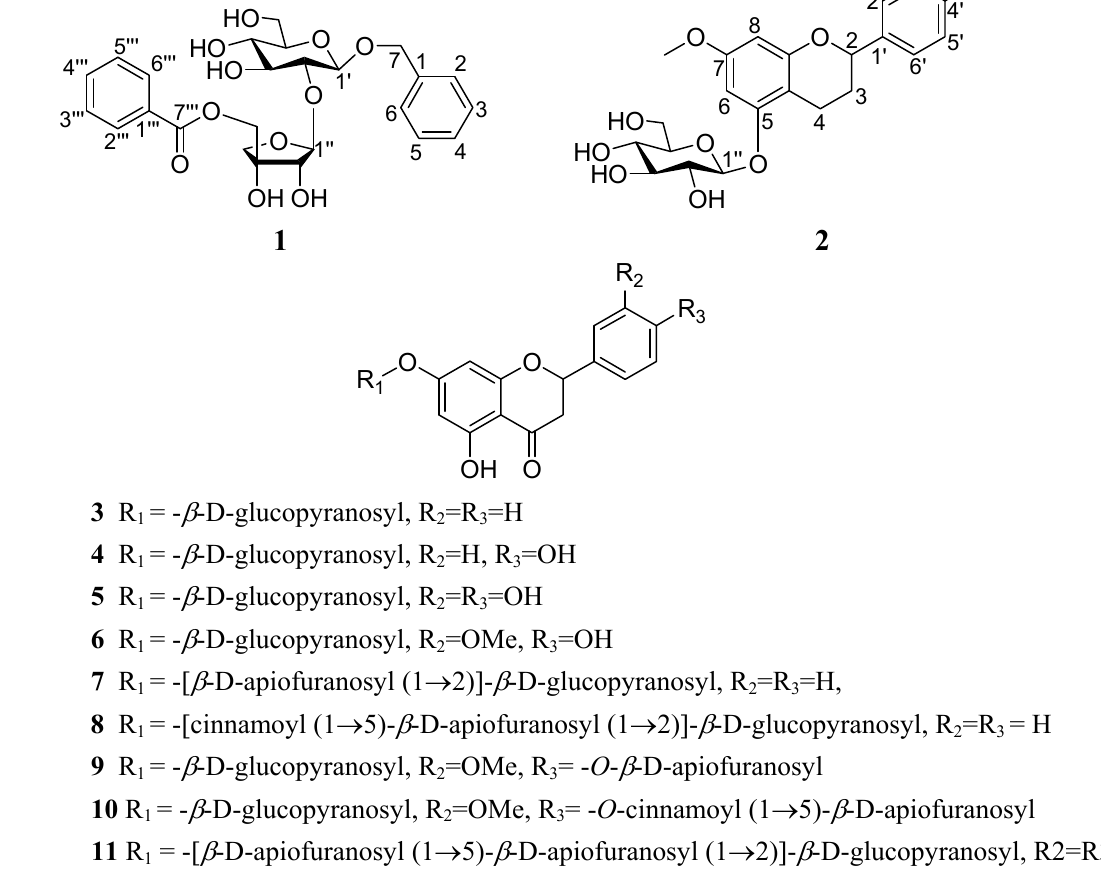
Figure 1. The structures of the isolated compounds 1 − 11 from V. articulatum